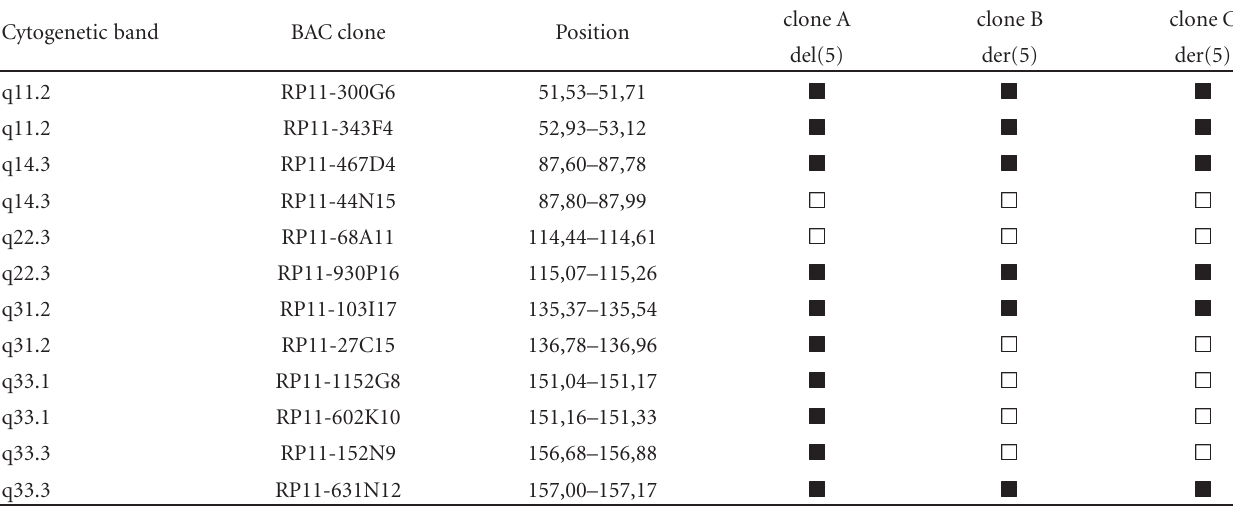
Table 1: FISH results with BAC clones located on the long arm of chromosome 5. Delineation of deleted ( chromosome 5 in clones A, B, and C.